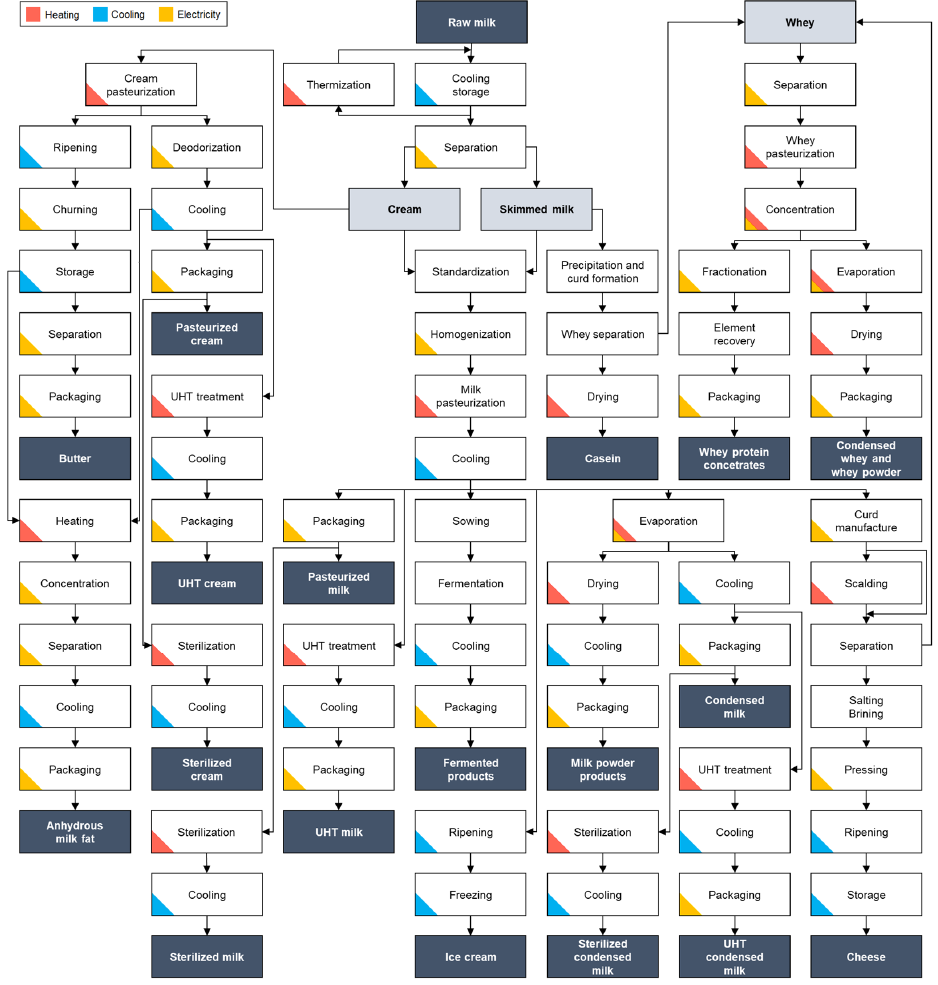
Figure 7. Map of the dairy processing industry. Adapted from [47].